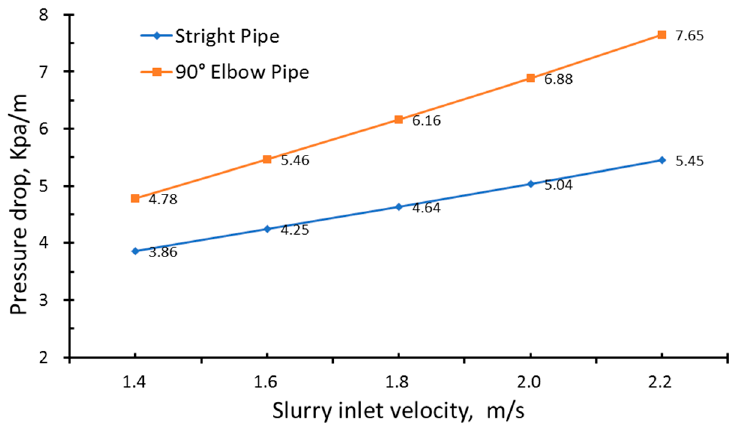
Figure 5. The pressure drops under the different conveying velocities.